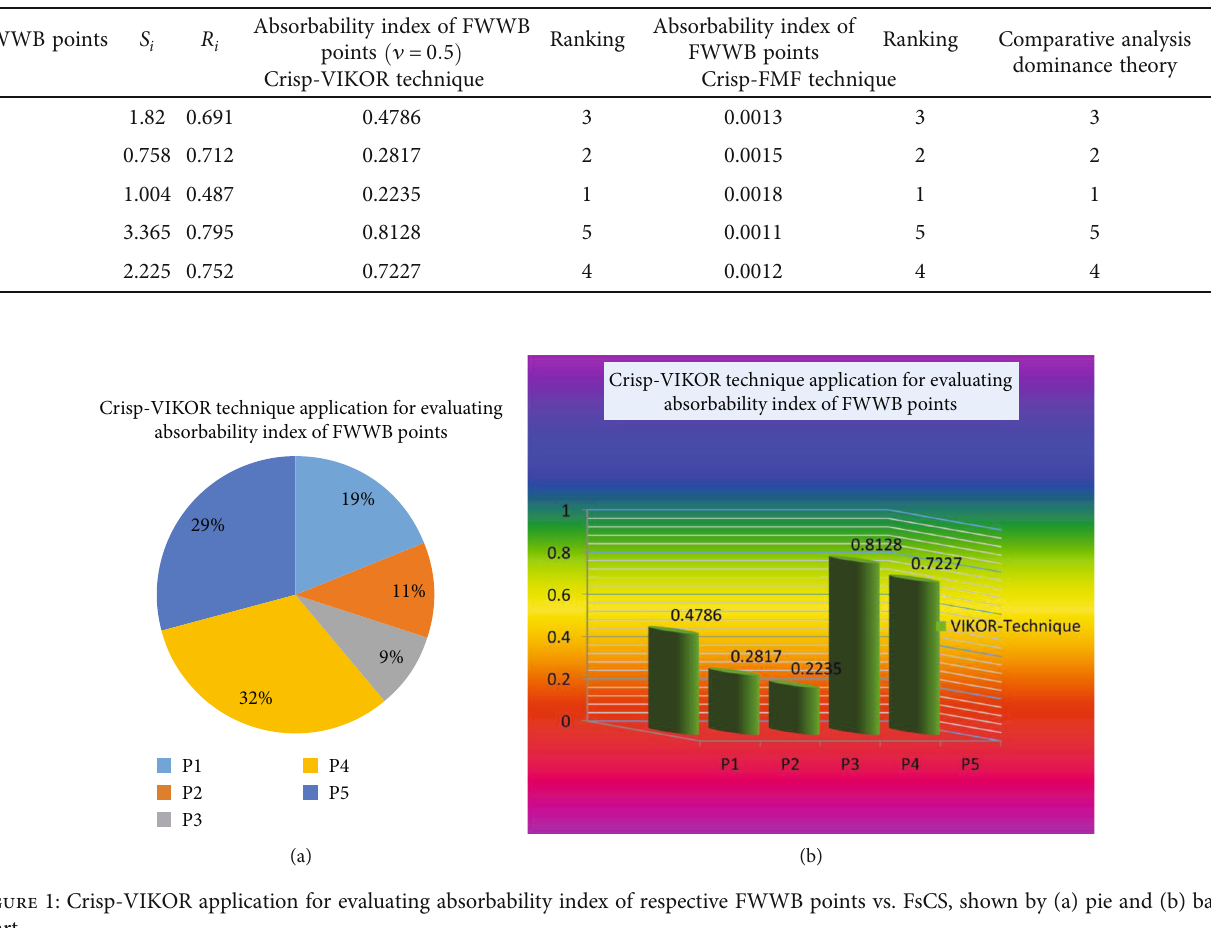
Table 10: Tabulated cumulative values corresponding to FWWB points.